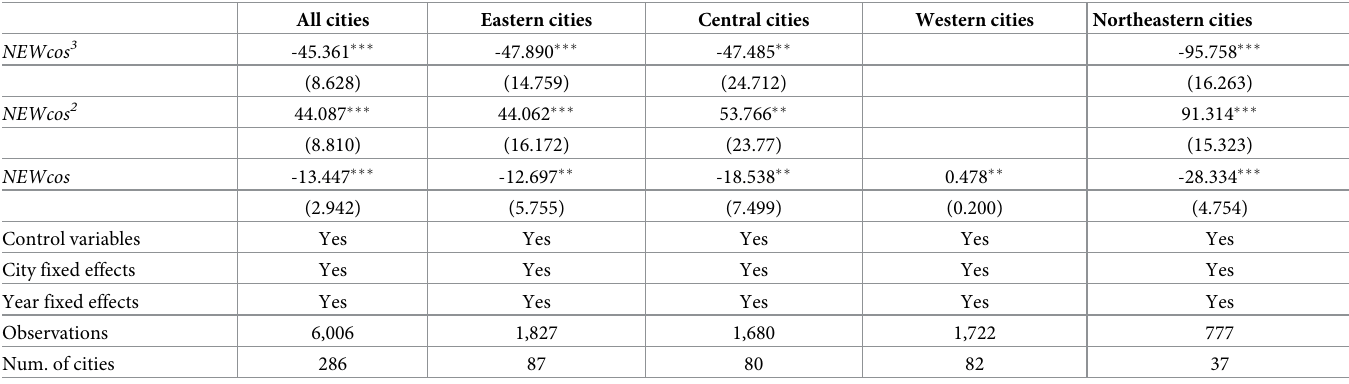
Table 6. Significant results summary of Eq (38) by the new weight (dependent variable: lnrpgdp ). All